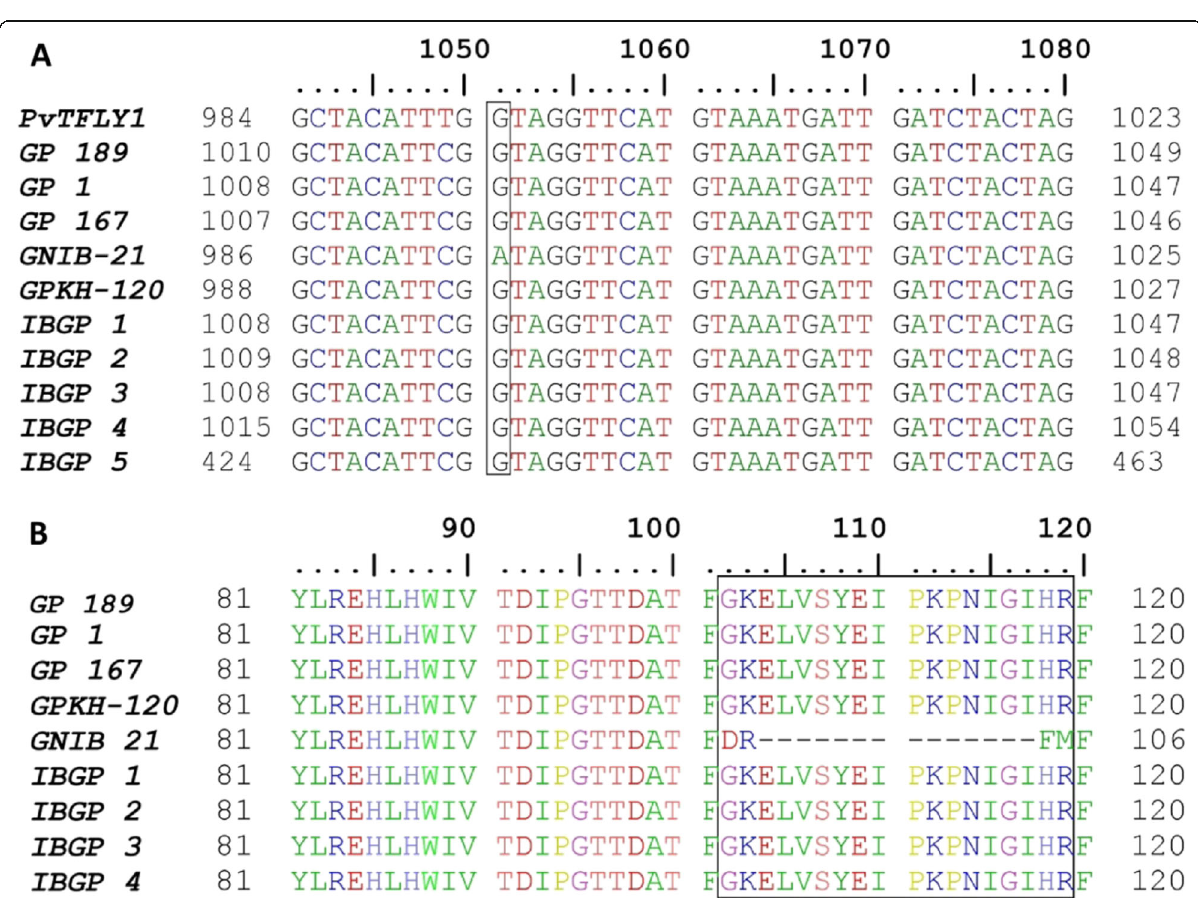
Fig. 2 Multiple sequence alignment of Indian bean genotypes. GNIB 21 is a determinate type, and the remaining genotypes are indeterminate. a DNA sequence alignment of ten genotypes. Splice site transition from G to A creating SNP at the end of the third exon is shown by a rectangle. b Protein sequence alignment of nine genotypes of Indian bean and PvTFL1y of common bean. Fourteen amino acids (from position 104 to 117) missing and amino acid substitutions in GNIB 21 due to splice site transition are shown by a